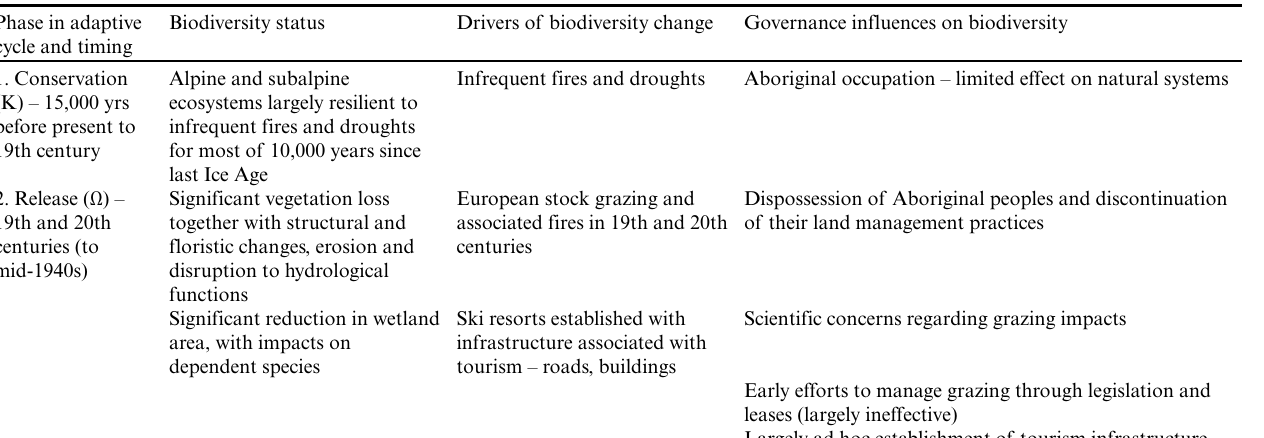
Table 3 . Adaptive cycle for the Alps focal